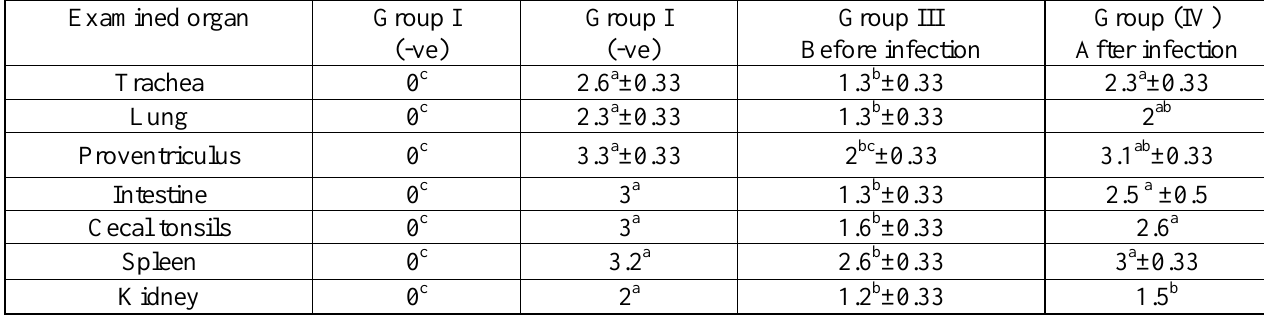
Table 5: Effect of 1 gm of ECV extract on post-mortem lesion scores in Sasso chickens after challenge with